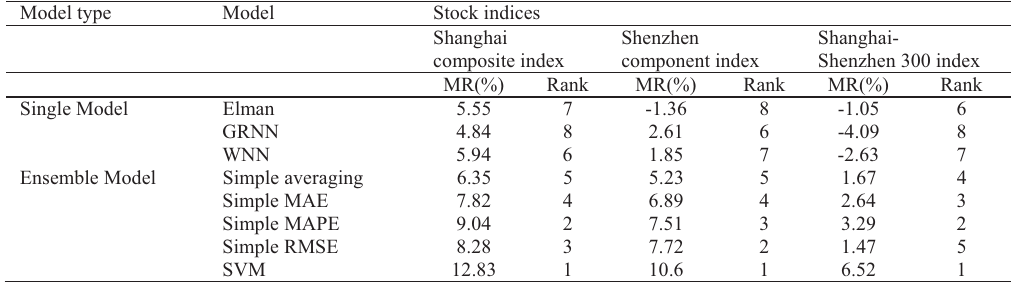
Table 6. Comparison of performance of MR averaging each model over 20 runs.